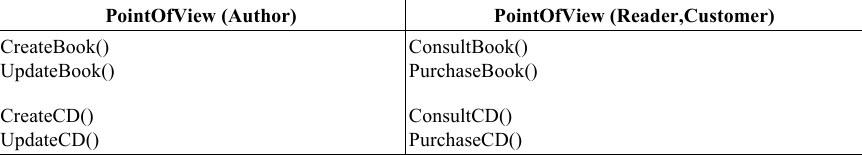
Table 5. A unique automatically generated Points of view of the Online Library study